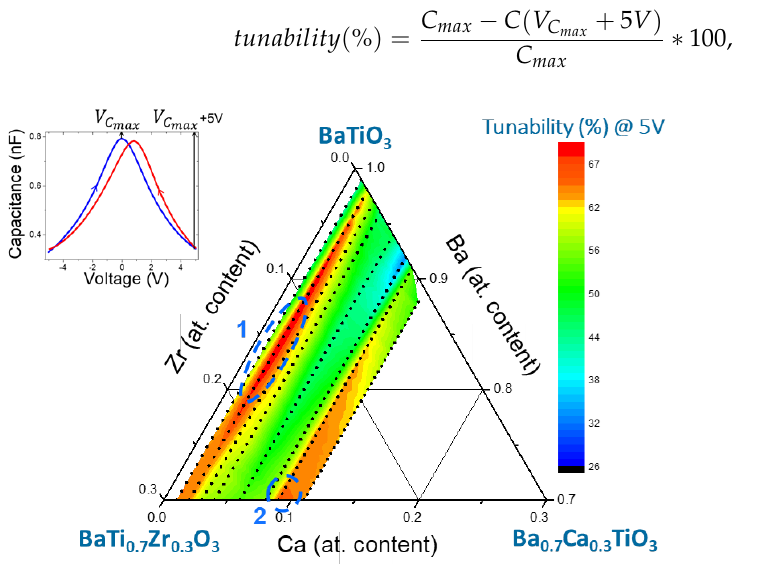
Figure 2. Fast initial screening tunability map (5 V amplitude). The black dots are the actual data points. Top-left is a typical hysteretical C(V) curve.